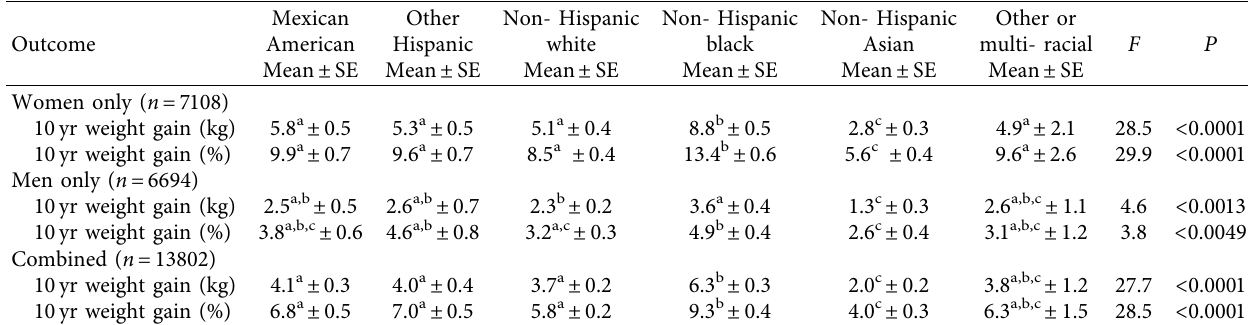
Table 5: Differences in 10-year weight gain across U.S. races, separated by sex, after adjusting for the covtablecaptionariates. Outcome